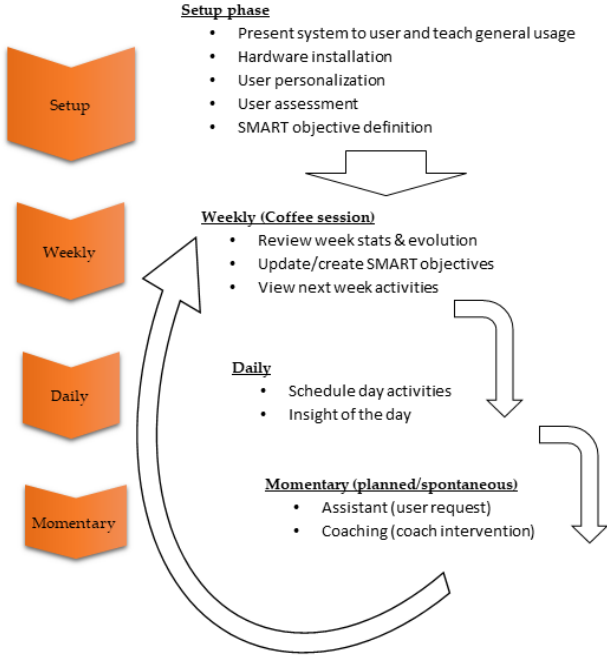
Figure 7. Proposed older adult coaching framework.